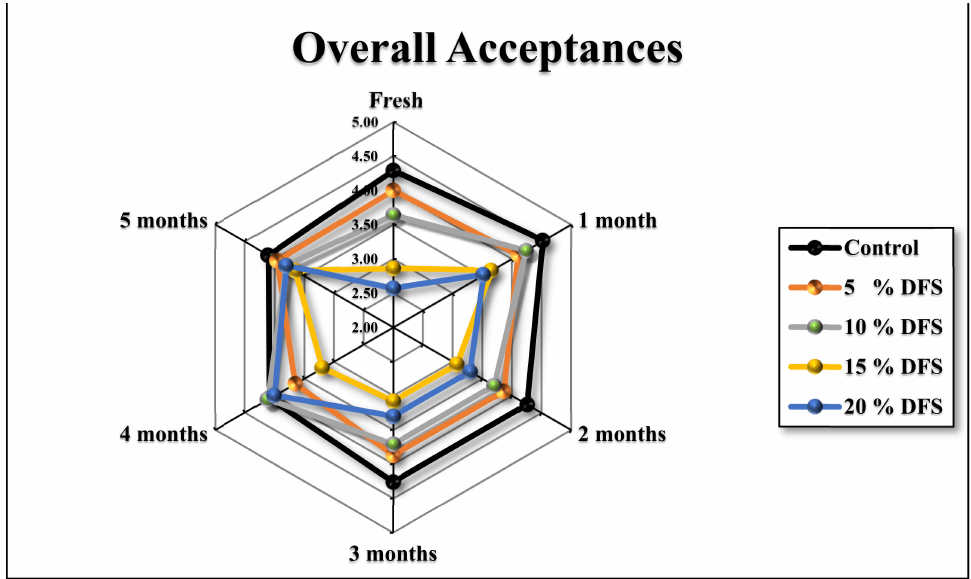
Figure 8. Overall acceptances of cheeses fortified with 5%, 10%, 15%, and 20% DFS as a partial substitution for butter during